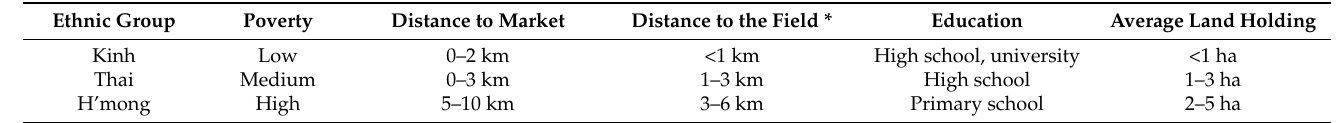
Table 2. Typical social characteristics of three main ethnic groups in northwest Viet Nam. Ethnic Group Poverty Distance to Market Distance to the Field * Education Average Land Holding